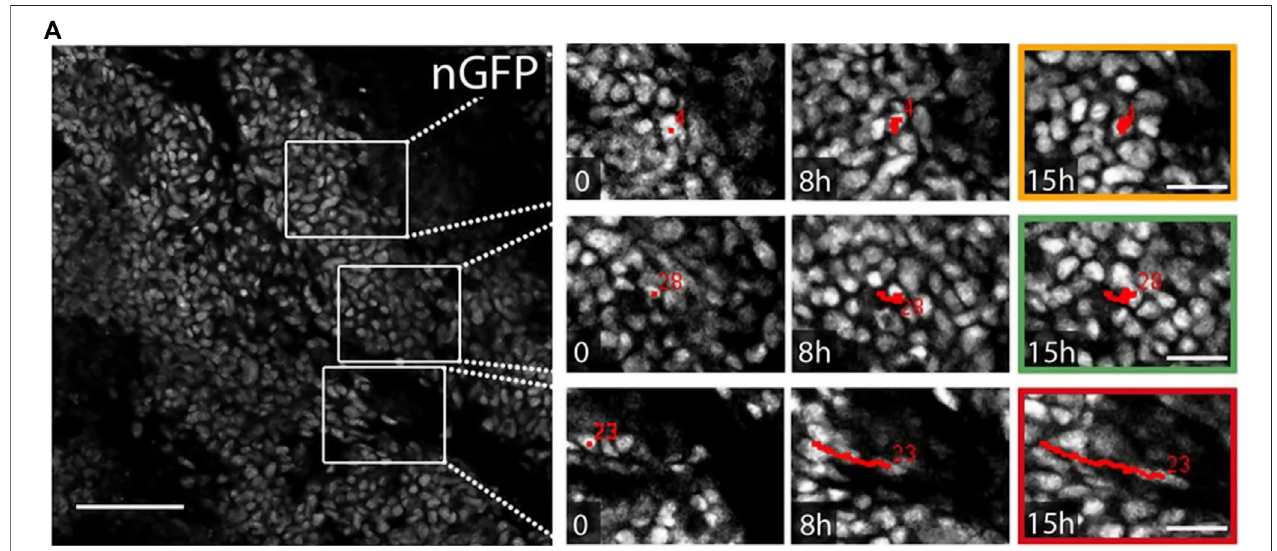
FIGURE3 | Tumorshave jammed and unjammedregions. Cell migration tracks inthe core oftumor explantsfrom mice. The ex vivo tumor shows jammed regions with resting cells (yellow box) and unjammed regions with moving cells (green and red box). The unjammed areas display different migration dynamics, with high (red) or lower (green) persistence. Red numbers represent the track ID numbers. Nuclei are stained with nuclear-targeting GFP (nGFP). Scale bar 100 μ m. Images were taken and adapted from Staneva et al. [55], Copyright ID 1096785 – 1.